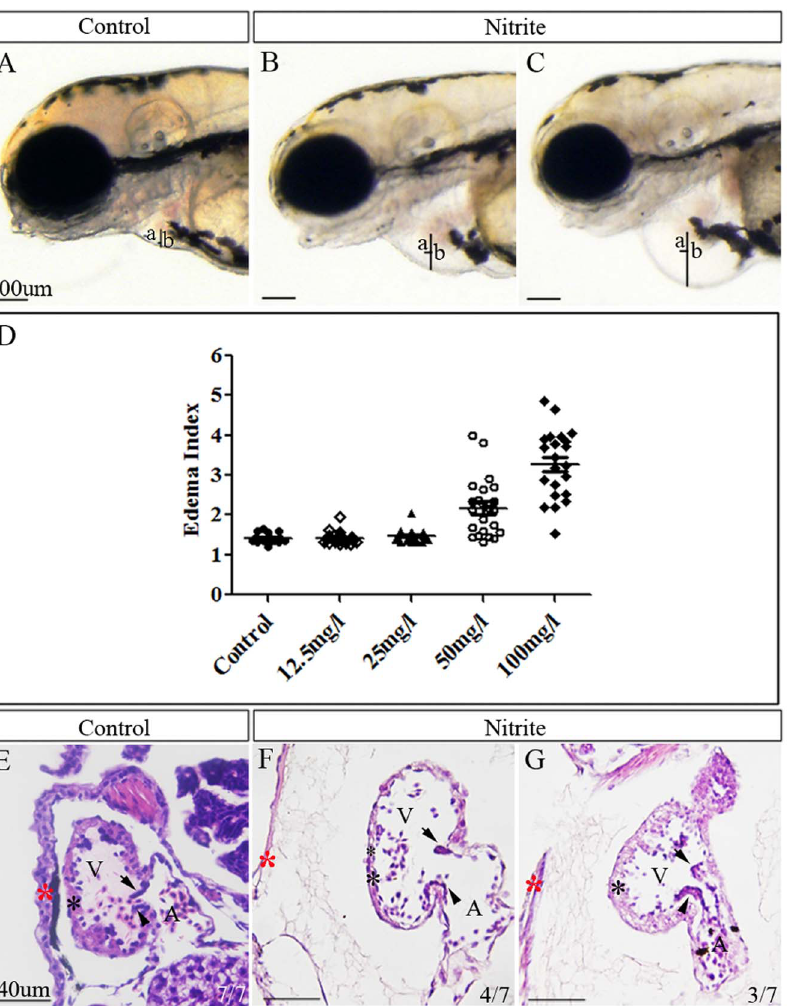
Figure 1. Sodium nitrite caused defective development of zebrafish heart in a dose dependent way. (A–C) Zebrafish embryos exposed to 100 mg/l sodium nitrite from 10 hpf exhibited cardiac edema from slight phenotype (B) to severe phenotype (C) compared to control embryos with normal heart (A) at 108 hpf. (D) A scatter plot showing the edema index (EI) of embryos exposed with different concentration of sodium nitrite. EI is defined as b/a. Average 6 standard errors of EIs were shown in lines. (E–G) Histological sections showing 100 mg/l sodium nitrite exposure caused defective structure of zebrafish heart at 108 hpf. Compared to control embryos with normal pericardial membrane, myocardium and both superior and inferior valve leaflets (E), 4/7 embryos exposed to the nitrite showed thinner pericardial membrane and myocardium, and only superior valve leaflet but no formation of inferior valve leaflet (F), whereas 3/7 of the treated embryos displayed thinner pericardial membrane and myocardium and no formation of either superior or inferior leaflets (G). a: the semi-diameter of ventricle; b: the semi-diameter of the pericardial cavity. Red star (*): pericardial membrane; Black star (*): myocardium; Black arrow: position of superior valve leaflet; Black arrowhead: position of inferior valve leaflet; A: atria; V: ventricle. doi:10.1371/journal.pone.0092728.g001 from 10–36 hpf (EI= 1.36 6 0.12, n= 21) displayed similar EI to that of control embryos (EI= 1.42 6 0.16, n= 18) (p . 0.05), and the EI of the embryos exposed to nitrite from 36–48 hpf (EI= 1.61 6 0.11, n= 16) was bigger (p , 0.01) than control embryos, smaller than (p , 0.01) that of the embryos treated with nitrite from 48–108 hpf, but similar to (p . 0.05) that of the embryos treated with nitrite from 76–108 hpf. Taken together, our results suggested that exposure of excessive nitrite before 36 hpf had no toxic effect on zebrafish heart development and the continuous exposure of nitrite after 36 hpf was responsible for the abnormal heart development of zebrafish embryos.